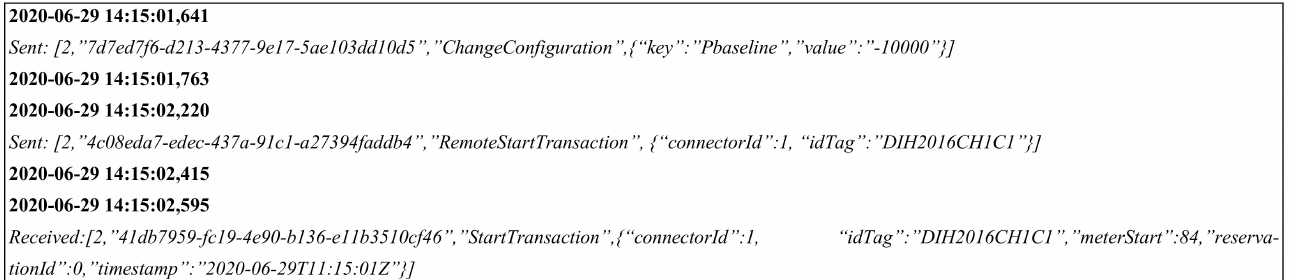
Figure 13. Communication between SGIP and AME charger through